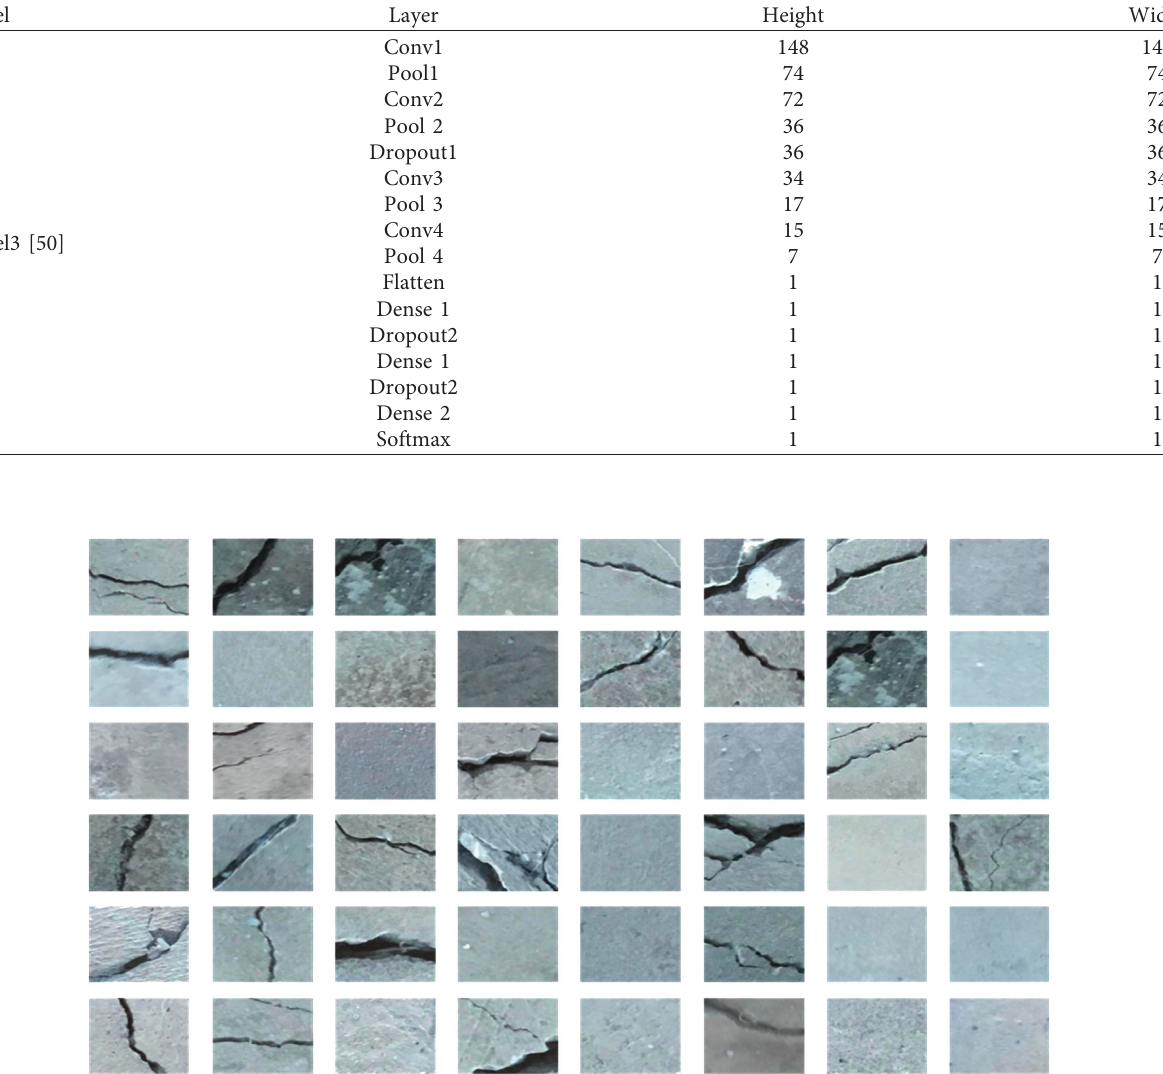
Table 3: Layer dimensions and operations.